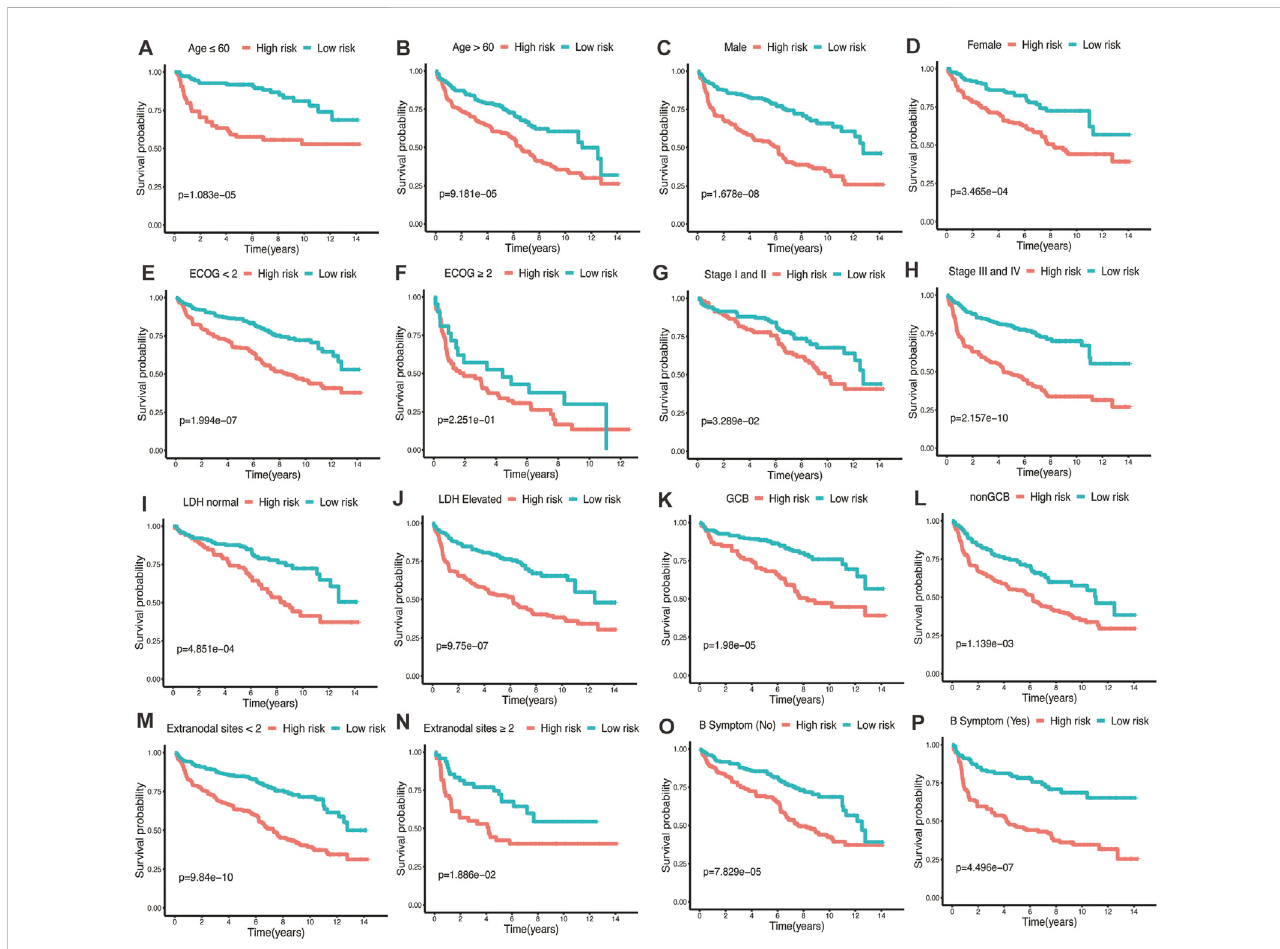
FIGURE 4 Performance of glycolytic risk model in subgroups of clinical factors. Kaplan-Meier analyses of overall survival for high- and low-risk patients in the subgroups of age (A, B) , gender (C, D) , ECOG-PS (E, F) , stage (G, H) , LDH level (I, J) , COO (K, L) , number of extranodal sites (M, N) , and B symptoms (O, P) . ECOG-PS, Eastern Cooperative Oncology Group performance status; LDH, lactate dehydrogenase; COO, cell of